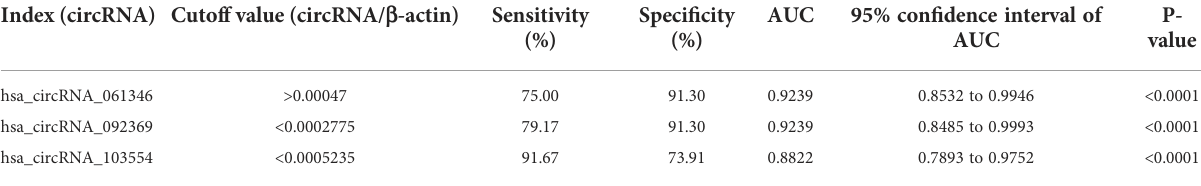
TABLE 4 Diagnostic values of the potential biomarkers of the patients with retinopathy of prematurity (ROP).